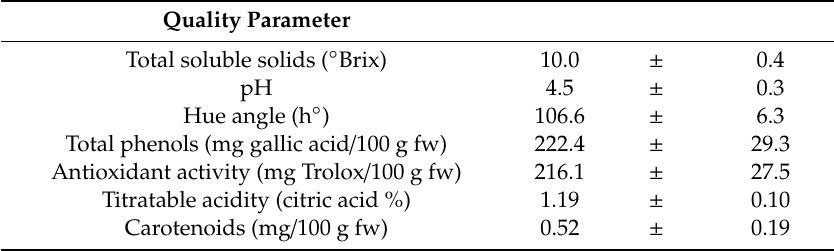
Figure 4. Changes in respiration rate ( A ), weight loss ( B ), visual quality ( C ) and firmness ( D ) in blueberries (cv Rebel) stored in Active-pMA or in air (Control) for 13 days at 8 °C. Data are mean values ( n = 3) ± standard deviation.